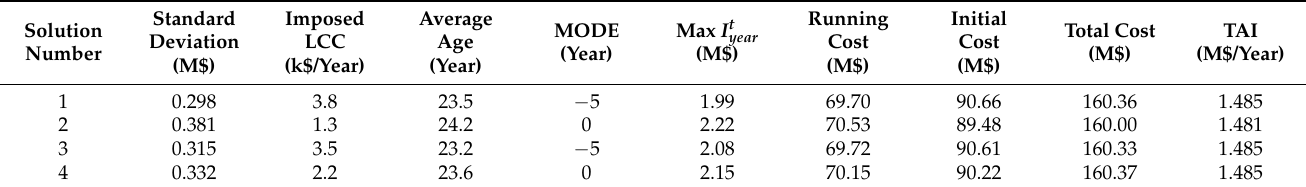
Table 4. Details of four selected points for Scenario 1 (replacement time boundary = ± 5 years, annual budget limit = 2.5 M$). Solution Number